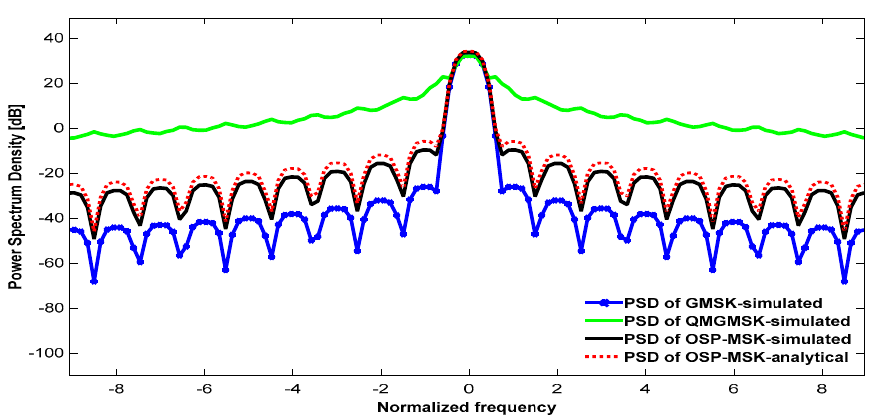
Figure 9. The power spectral density (PSD) of the proposed OSP-MSK compared to the PSDs of GMSK and QMGMSK.